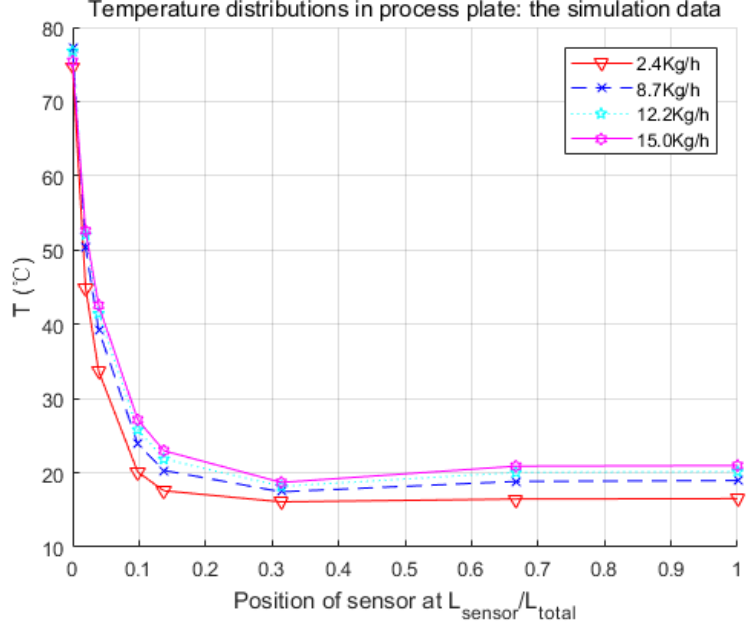
Figure 11. Simulation results of the process fluid temperature along the channel for different process flow rates, with 𝑀(cid:4662) (cid:3048) = 152 kg·h − 1 and 𝑇 (cid:3048)(cid:2879)(cid:3036)(cid:3041) = 15.6 °C.